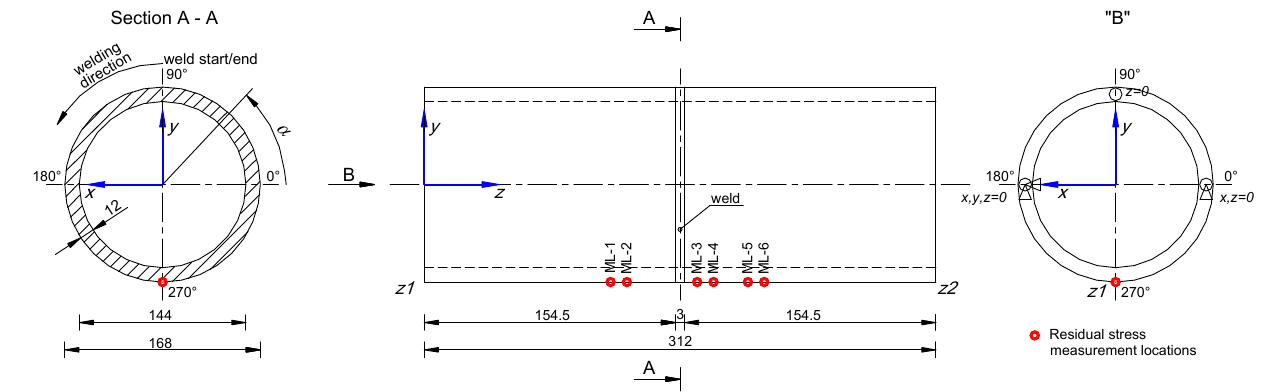
Figure 1. Pipes prepared for welding.